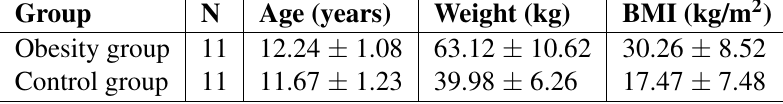
Table 1 Basic situation of experimental group and control